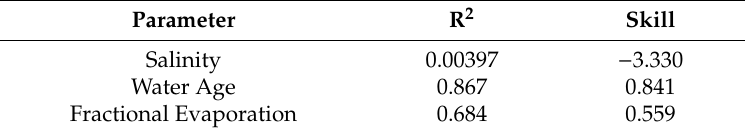
Table 3. Model performance metrics in comparisons to underway measurements.